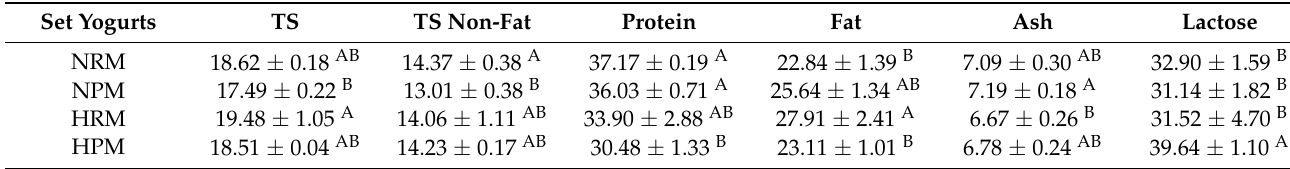
Table 1. Composition of set yogurts produced from raw milk or processed milk combined with Lacprodan ® PL20 on a dry-matter basis expressed as (g/100